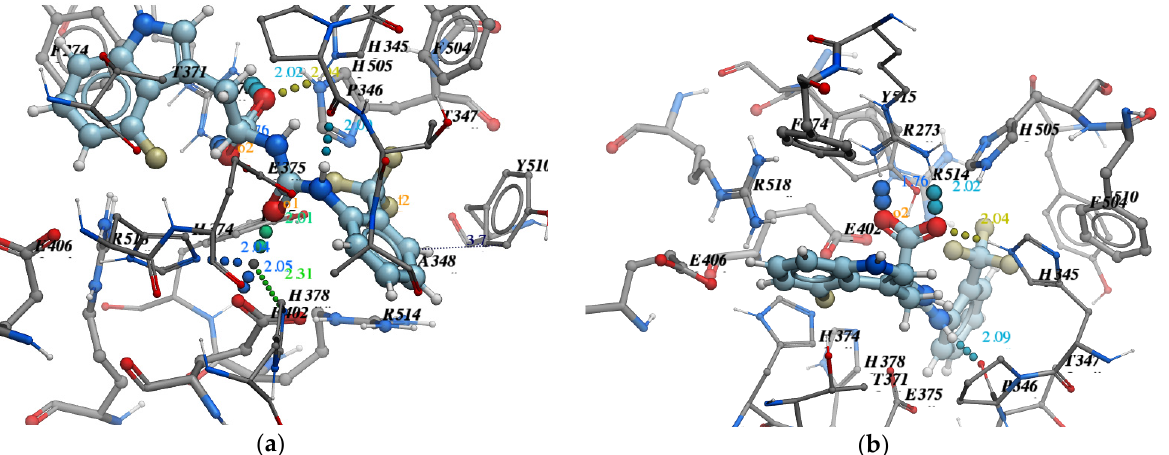
Figure 8. Important selection criteria for “cherry-picking”: ( a ) pose accuracy relative to ARG273; ( b ) pose accuracy relative to Zn 2+ .